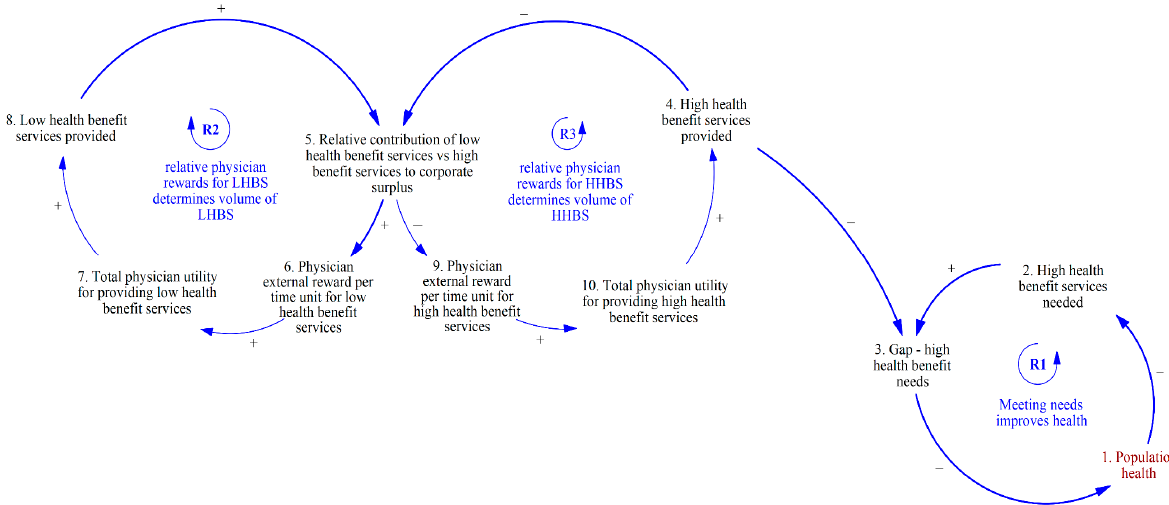
Figure 2. Competing dynamics for the provision of LHBS and HHBS within a corporation.